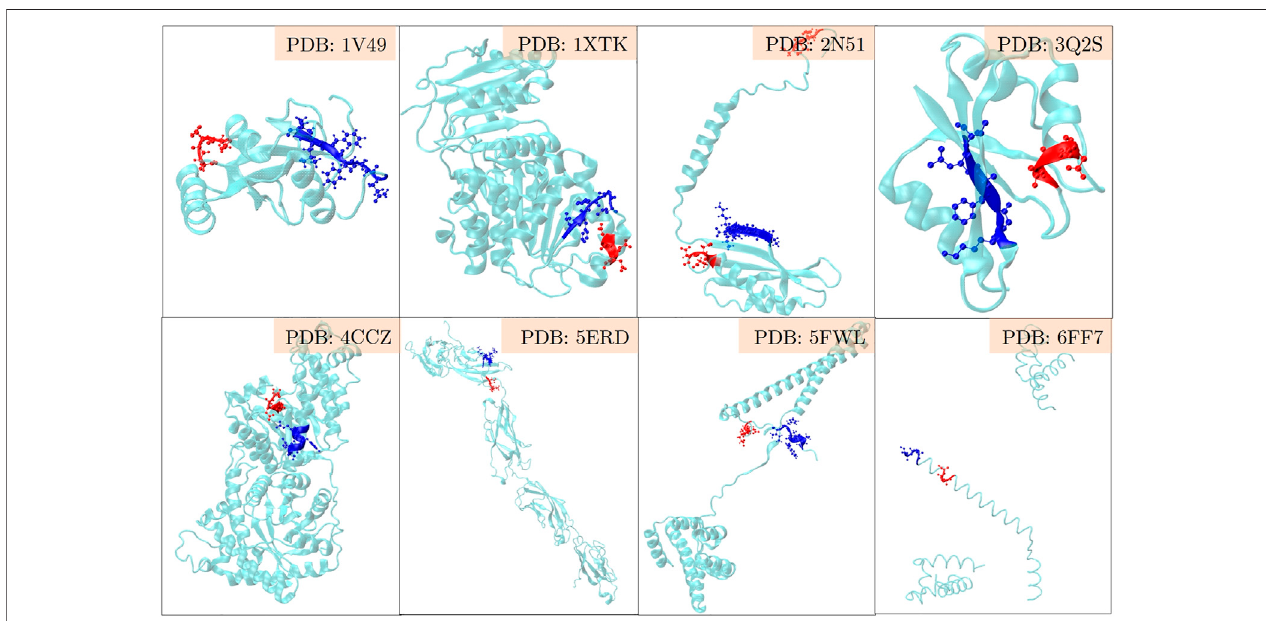
FIGURE 3 | An analysis of the structural-proximity of the triacidic motif with the LIR motif among the proteins from the class I of the UCPS-ATG data set for which structuresareknownisshown.TheblueandredcolorsindicatetheLIRandtriacidicmotifs.Forconvenience,onlytheclosestpairisshownandotheroccurrencesofLIR or triacidic motifs are not shown.